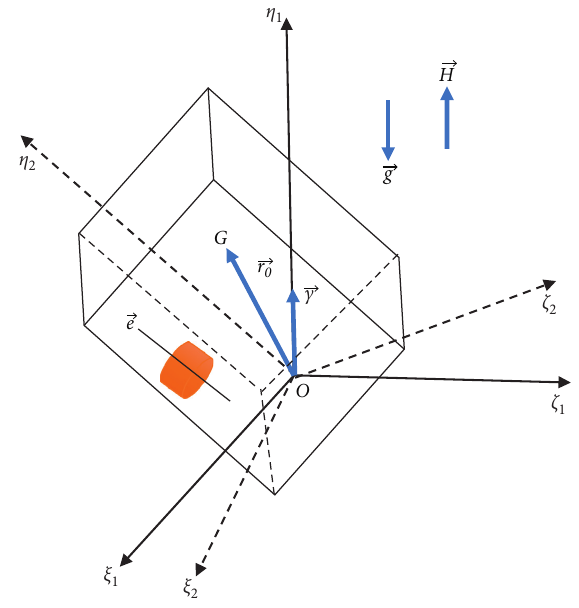
Figure 1: References frames and